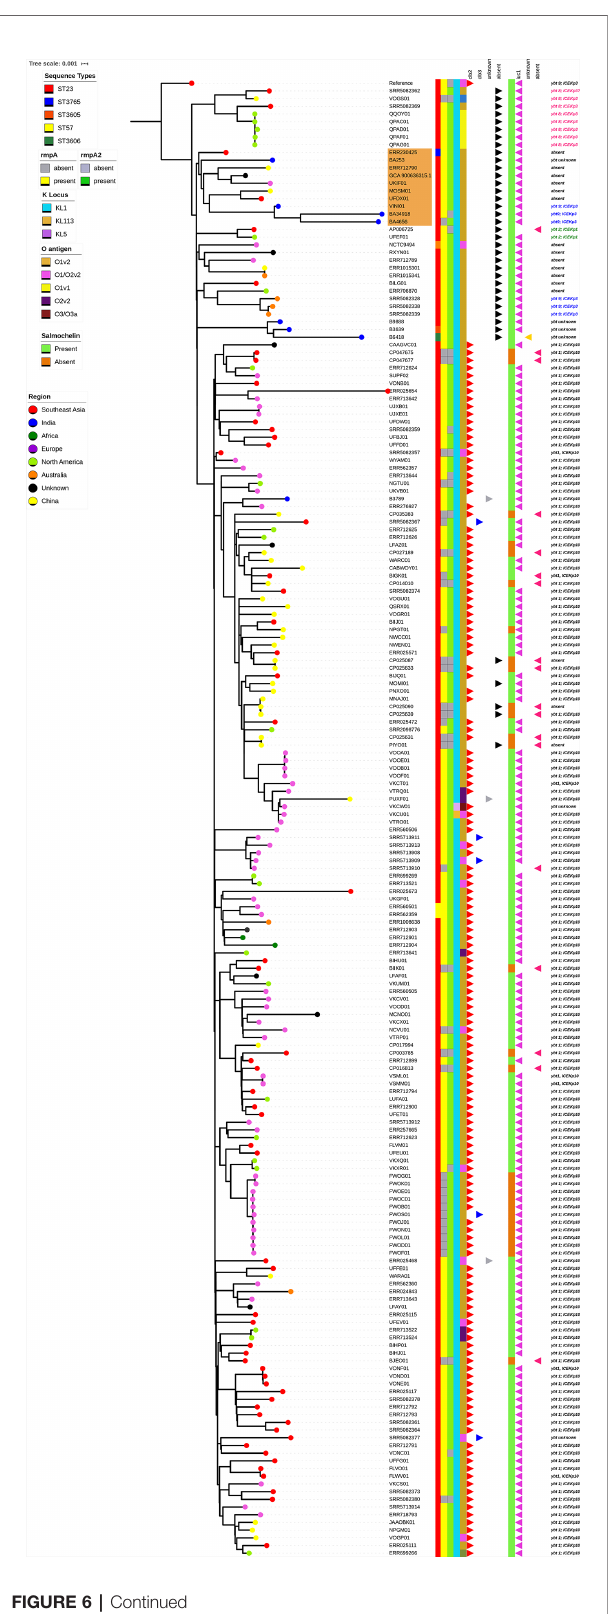
FIGURE 6 | Single nucleotide polymorphism (SNP) based phylogenetic tree based on the core genome alignment of 192 CG23 Klebsiella pneumoniae isolates from the global collection. The maximum likelihood phylogram is based on 9,300 SNPs after removing the recombinant regions. The phylogenetic tree was rooted by using the reference genome (ED23). The scale represents the evolutionary distances. The percentage of 100 bootstrap trials (100 replicates). The study isolates BA4656 and BA34918 formed a separate sub-lineage with 10 isolates distributed around the world in the phylogenetic tree (highlighted in